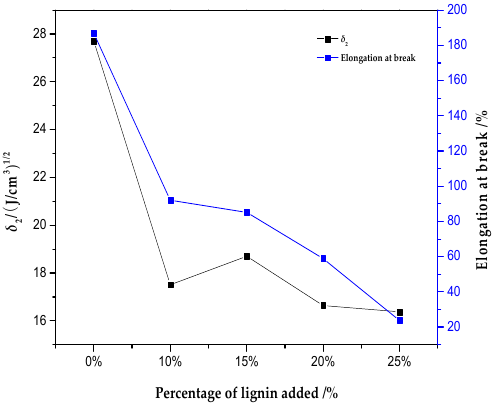
Figure 4. Effect of different proportions of alkali lignin on δ 2 and elongation at break.